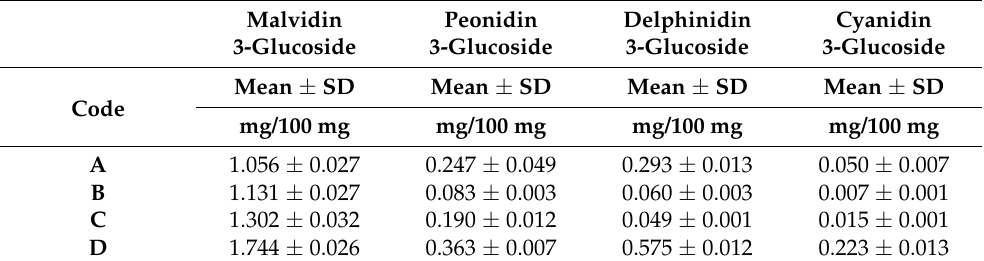
Table 1. Absolute quantitative content of anthocyanin determined by